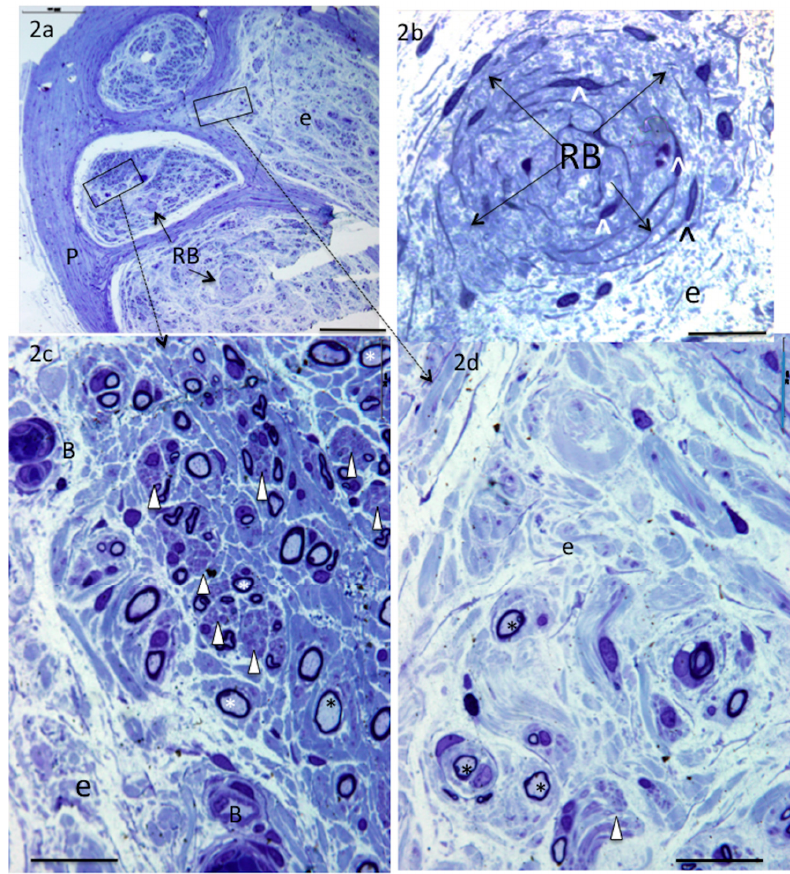
Figure 2. Toluidine blue-stained sections from nerves to teres minor. Nerves to teres minor and the posterior branch of axillary showed evidence of compression injury. Note thickened perineurium ( a